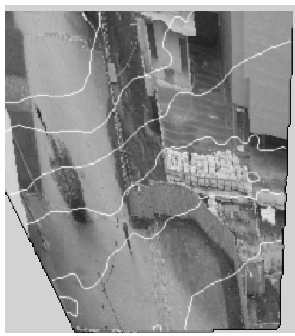
Figure 7. Fragment from orthophotographic rectification results with contours (interval 0.5 m) overlaid – Close Range